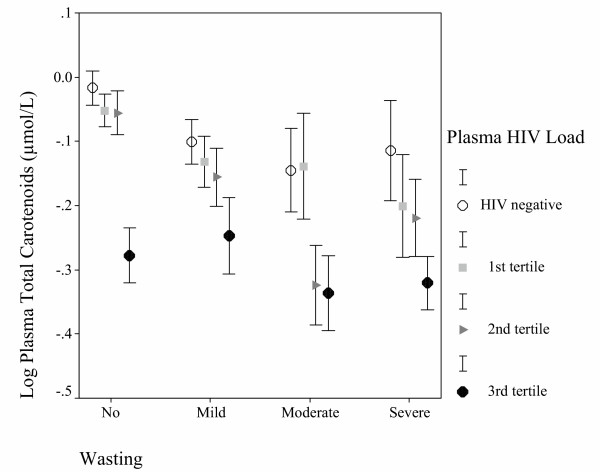
Log-transformed mean plasma total carotenoid concentrations with 95% C.I. are depicted by severity of wasting and plasma HIV load. Among not-wasted, mildly wasted, moderately wasted and severely wasted log mean plasma total carotenoid concentrations significantly decrease with the increase of plasma HIV load (P = 0.0001, P = 0.002, P = 0.001 and P = 0.001, respectively). Among the HIV negative adults, and those in the 1st and 2nd tertile of plasma HIV load, log mean plasma total carotenoid concentrations significantly decreased with the increasing severity of wasting (P = 0.007, P = 0.002 and P = 0.0001, respectively). This trend did not reach significance among those in the 3rd tertile of plasma HIV load.